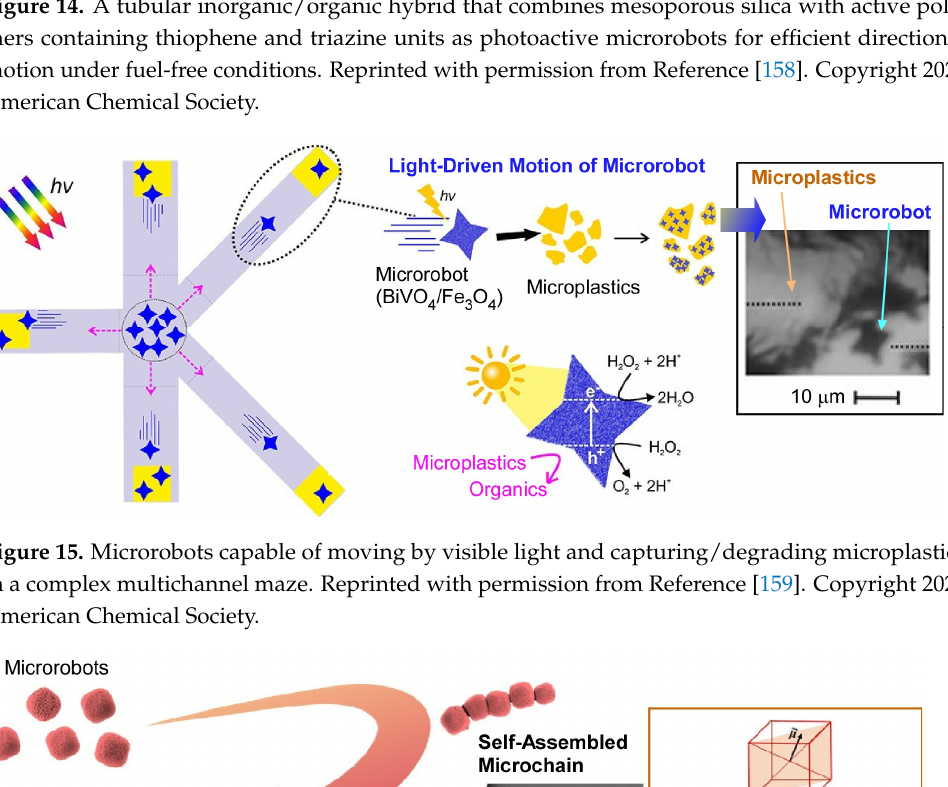
Figure 16. Shape-controlled microrobots to form chain-like aggregate structures. Reprinted with permission from Reference [160]. Copyright 2022 American Chemical Society. The ability to change its shape and size is also a useful property in the design of highly functional microrobots. In particular, more complex drug delivery operations such as drug encapsulation and release in practical biological applications also require that mi- crorobots have shape adaptability to dynamic environments. Li, Zhang, Wu, and co-